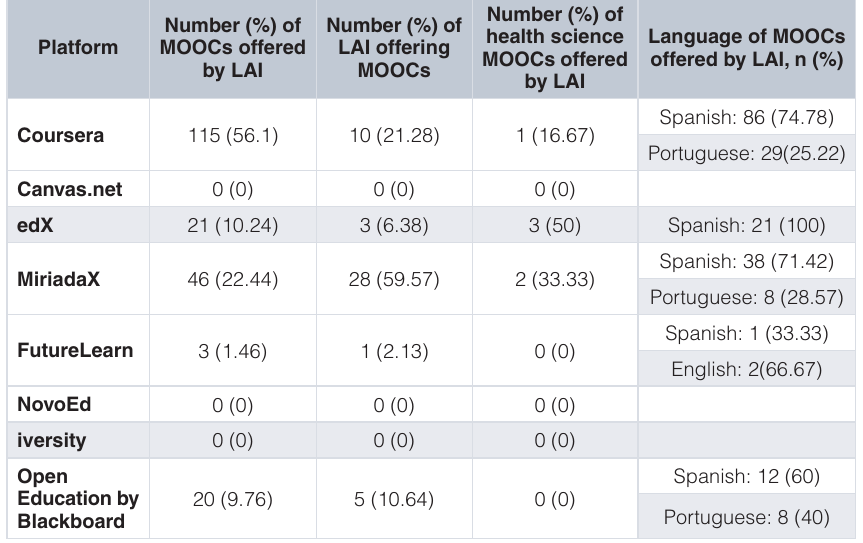
Table 1. Characteristics of massive open Online courses (MOOCs) offered by Latin American institutions (LAI).